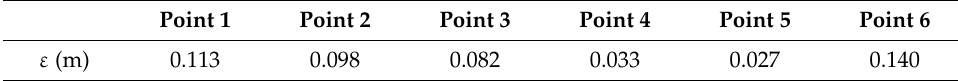
Figure 10. Plan view of the scanned area and overlapping point clouds for drift evaluation. Table 4. Drift evaluation of IMAS; inspection path: 31